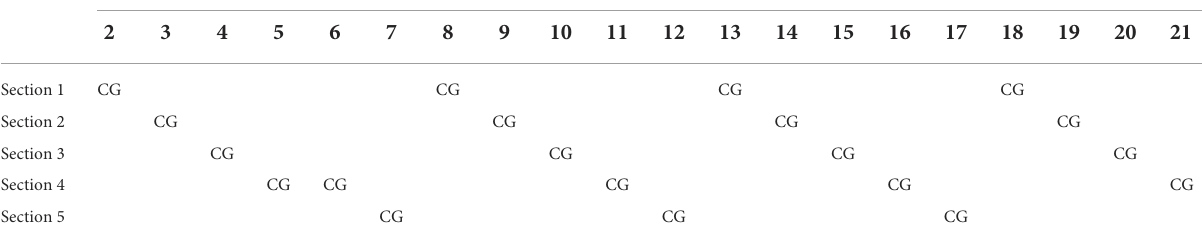
TABLE 1 Control group distribution during the term.